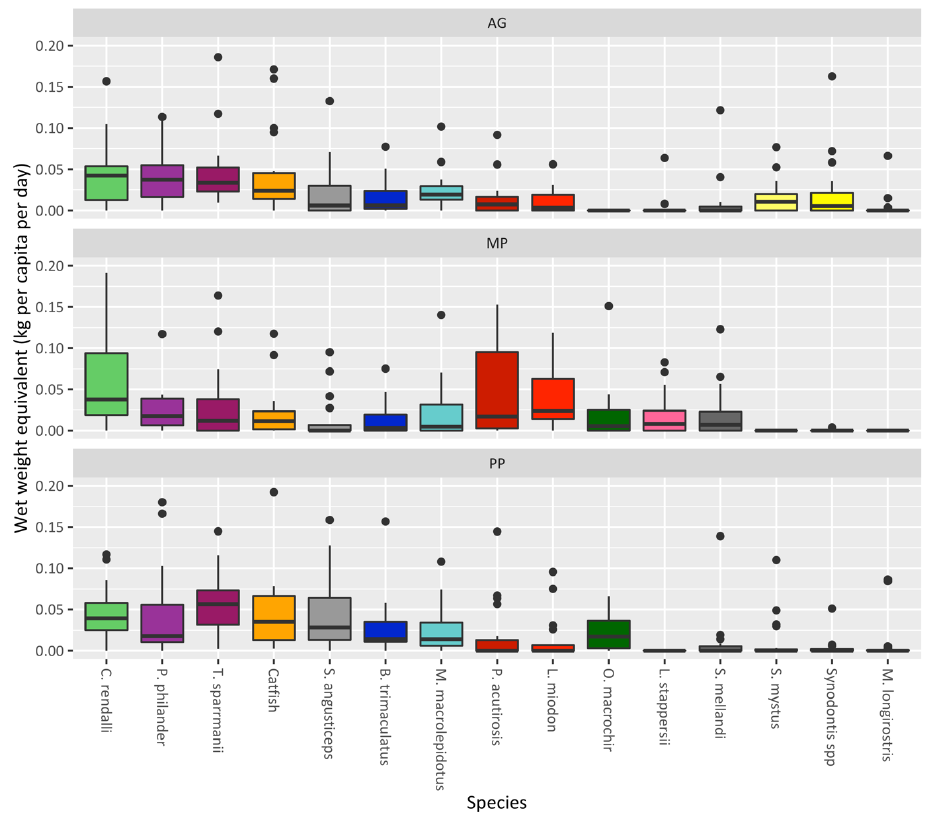
Figure 4. The average quantity of fish consumed (wet weight equivalent: kg species/capita/day), disaggregated by the three study groups. From left to right: the species are ordered as the most to least consumed fish on average for the whole sample of households over the entire study period, in terms of the total wet weight equivalent (kg). Outliers above 0.2 kg/capita/day have been truncated for clarity, thus removing 18 observations.